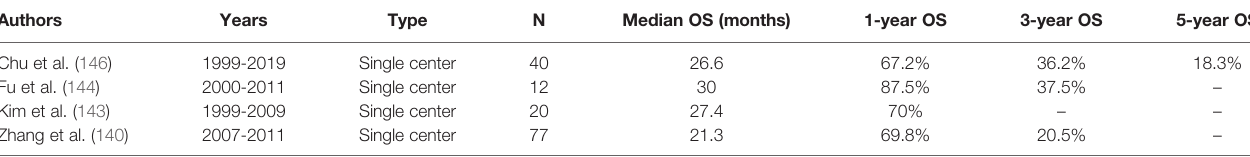
TABLE 4 | Survival after ablation for intrahepatic cholangiocarcinoma recurrence in the liver.